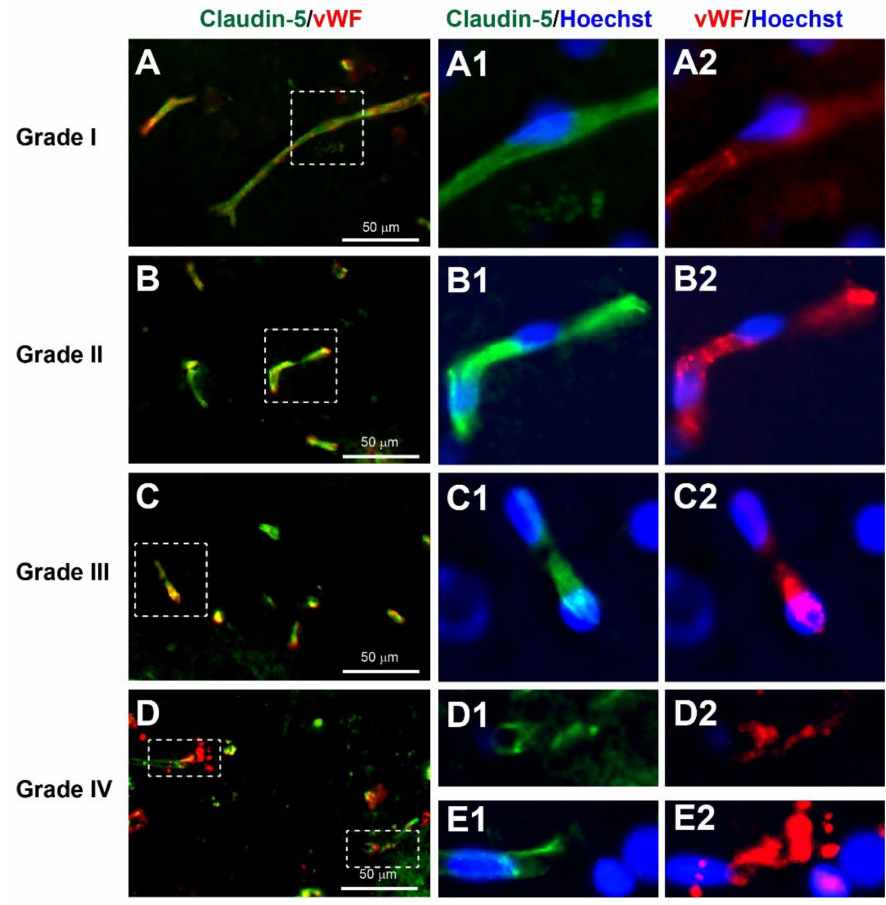
Figure 4. YHU grading system for neurovascular injury in cerebral biopsies immunostained with claudin-5 (green), von Willebrand factor (vWF, red), and Hoechst (nuclei, blue). ( A – A2 ) Microvessels with limited damage display moderate claudin-5 and vWF staining within long uninjured segments of microvessels (grade I). ( B – B2 ) Mildly damaged microvessels exhibit stronger claudin-5 and vWF staining, with shorter microvessel segments (grade II). ( C – C2 ) Moderately damage microvessels predominantly exhibit very short segments (grade III). ( D – E2 ) Severe microvessel damage is indicated by few, if any, claudin-5- or vWF-stained microvessels present and/or microvessels showing signs of bursting morphology, with release of vWF bodies (grade IV). ( A1 – E2 ) Enlarged images of the corresponding dashed boxes. Scale bar is 50 µ